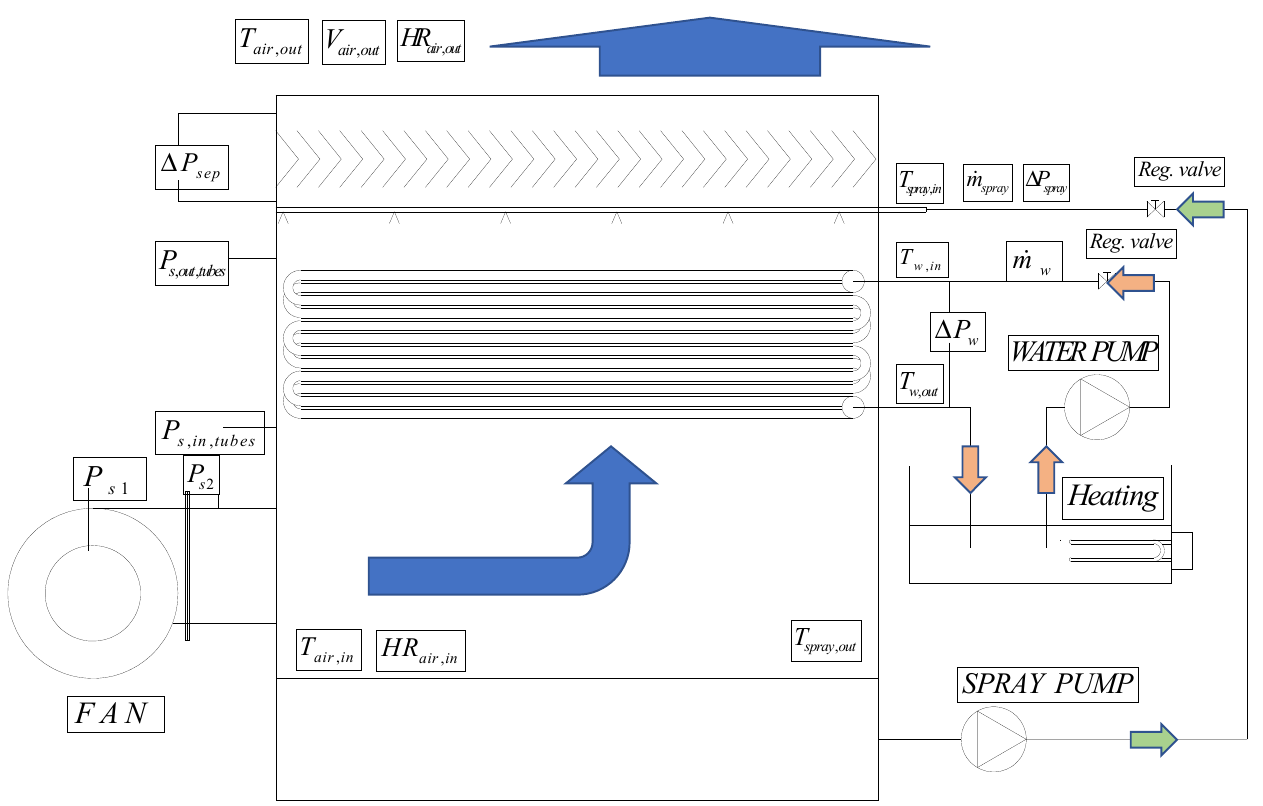
Figure 1. Closed circuit cooling tower and the fluid streams involved.